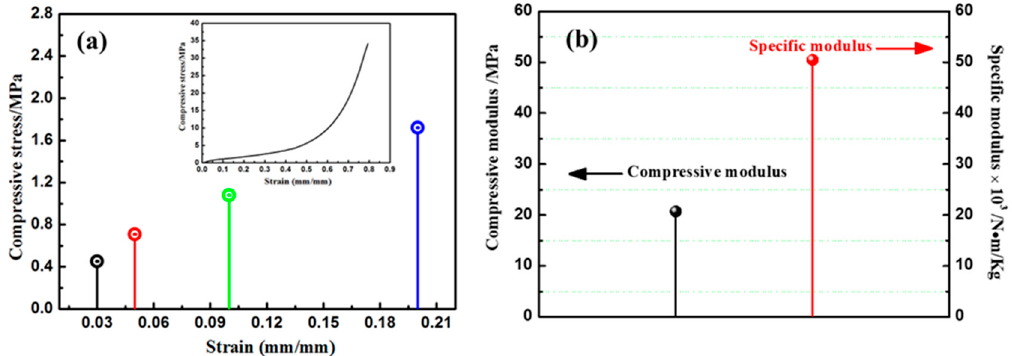
Figure 5. ( a ) Compressive strength at 3%, 5%, 10% and 20% strain, and corresponding compressive stress-strain curve (inset), ( b ) compressive modulus and specific modulus of the composites.